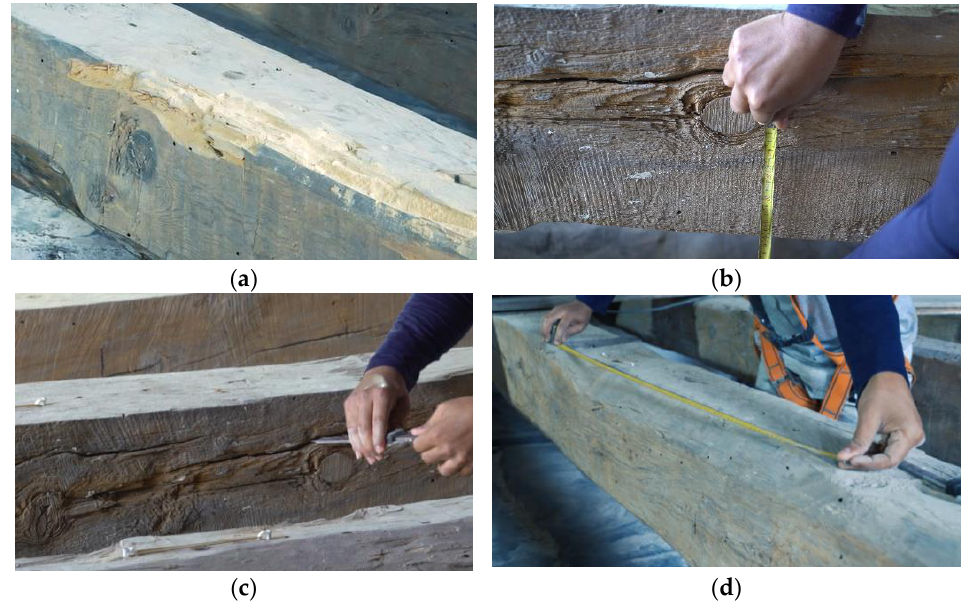
Figure 11. ( a ) Presence of woodworm; ( b ) Measurement of a knot; ( c ) Measurement of a split; ( d ) Measurement of wane.